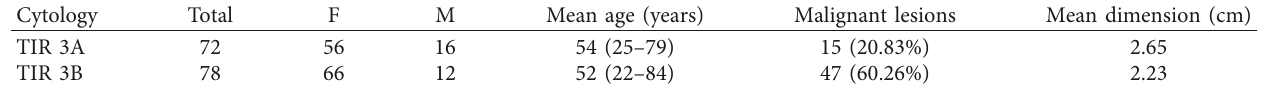
Table 2: Demographic characteristics of the study population.